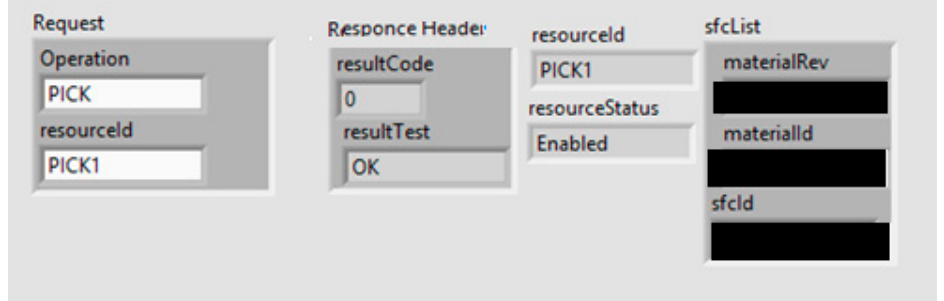
Figure 6. Front panel of ‘ WebserviceA ’ webservice (after edits) (sfcList data is not displayed because of its specific company product details).